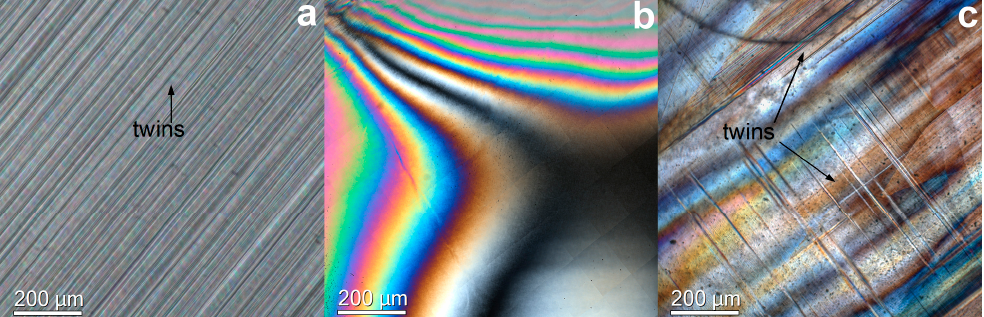
Figure 1. Typical optical images characteristics of tetragonal ( a ); cubic ( b ); rhombohedral ( c ).